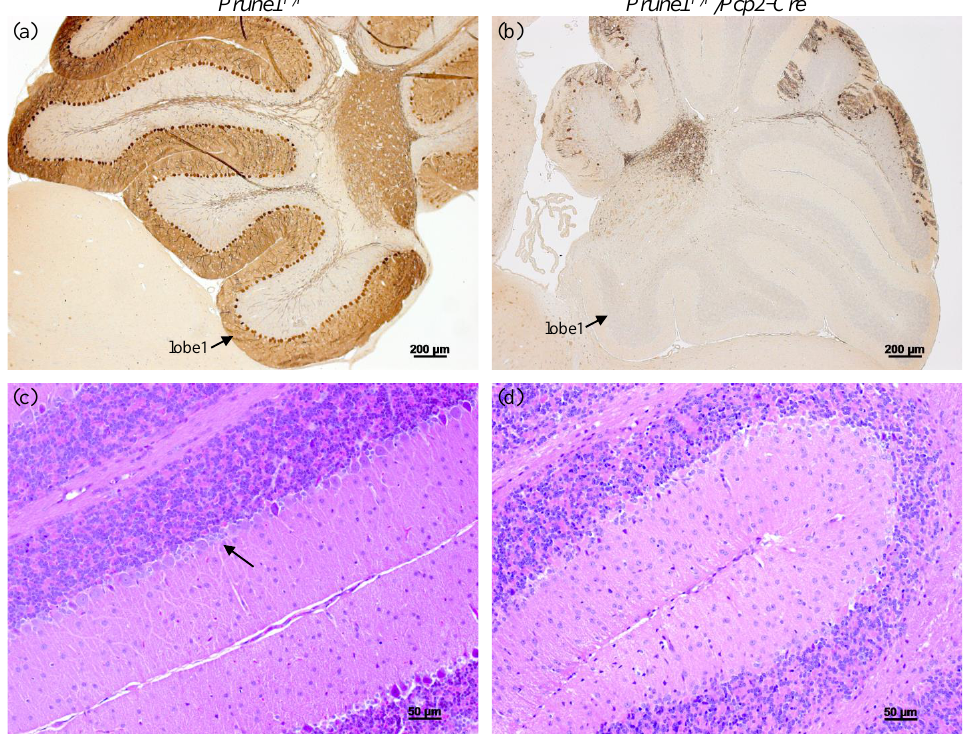
Figure 4. Characterization of the Prune1 F/F /Pcp2-Cre mice with conditional knockout of PRUNE1 in cerebellar Purkinje cells. ( a , b ) Immunostaining with anti-Calbindin antibody (a marker for Purkinje cell), demonstrating loss of more than 90% of Purkinje cells in two months old Prune1 F/F /Pcp2-Cre cerebella. Lobe 1 of the cerebellum is indicated. ( c , d ) H&E staining further confirming the loss of Purkinje cells in two months old Prune1 F/F /Pcp2-Cre cerebella. Arrow indicates Purkinje cell